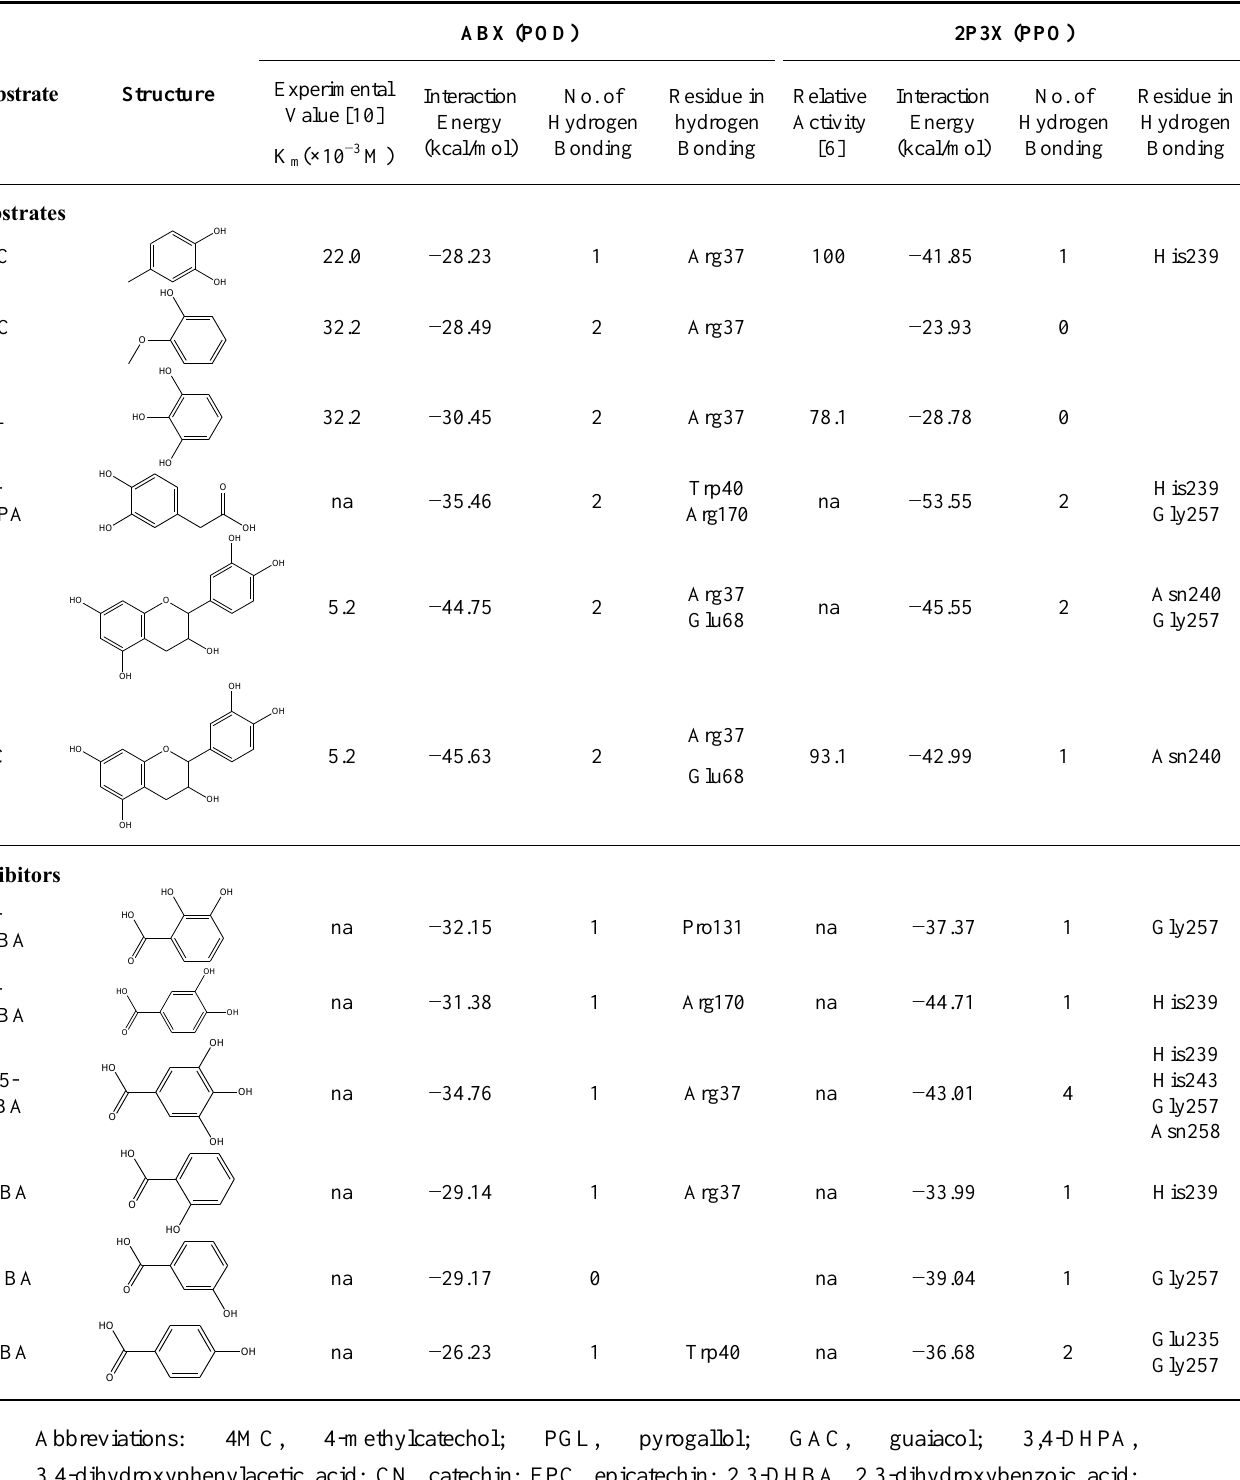
Table 2. Experimental predicted interaction of phenolic and benzoic acid compounds with grape ascorbate peroxidase and polyphenol